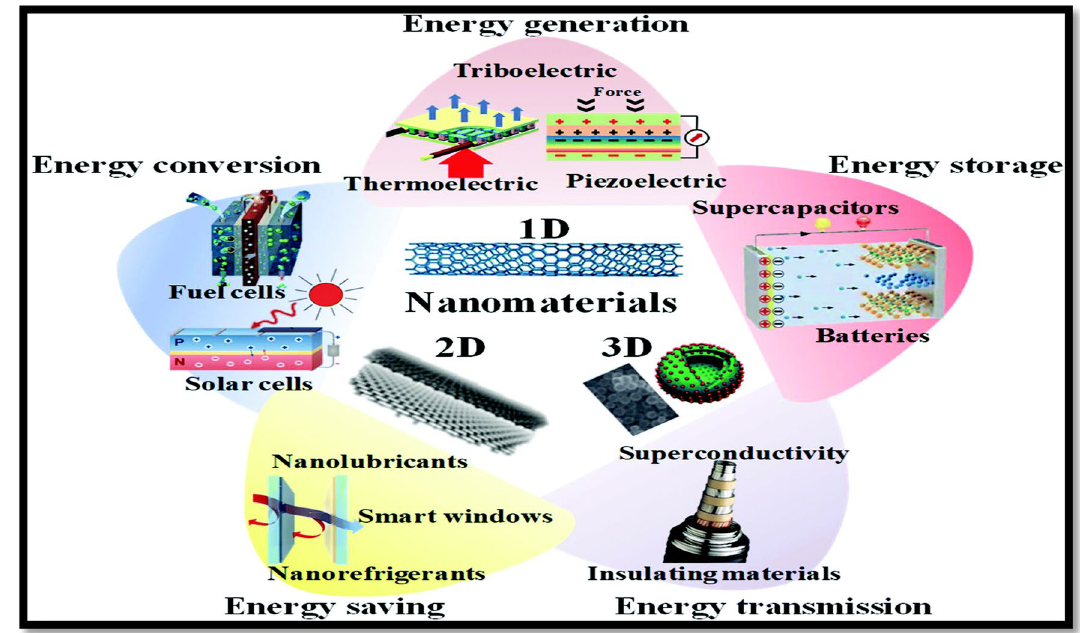
Fig. 3 Different energy applications: energy generation, storage, conversion, and saving up on nanomaterials substances (Wang et al.